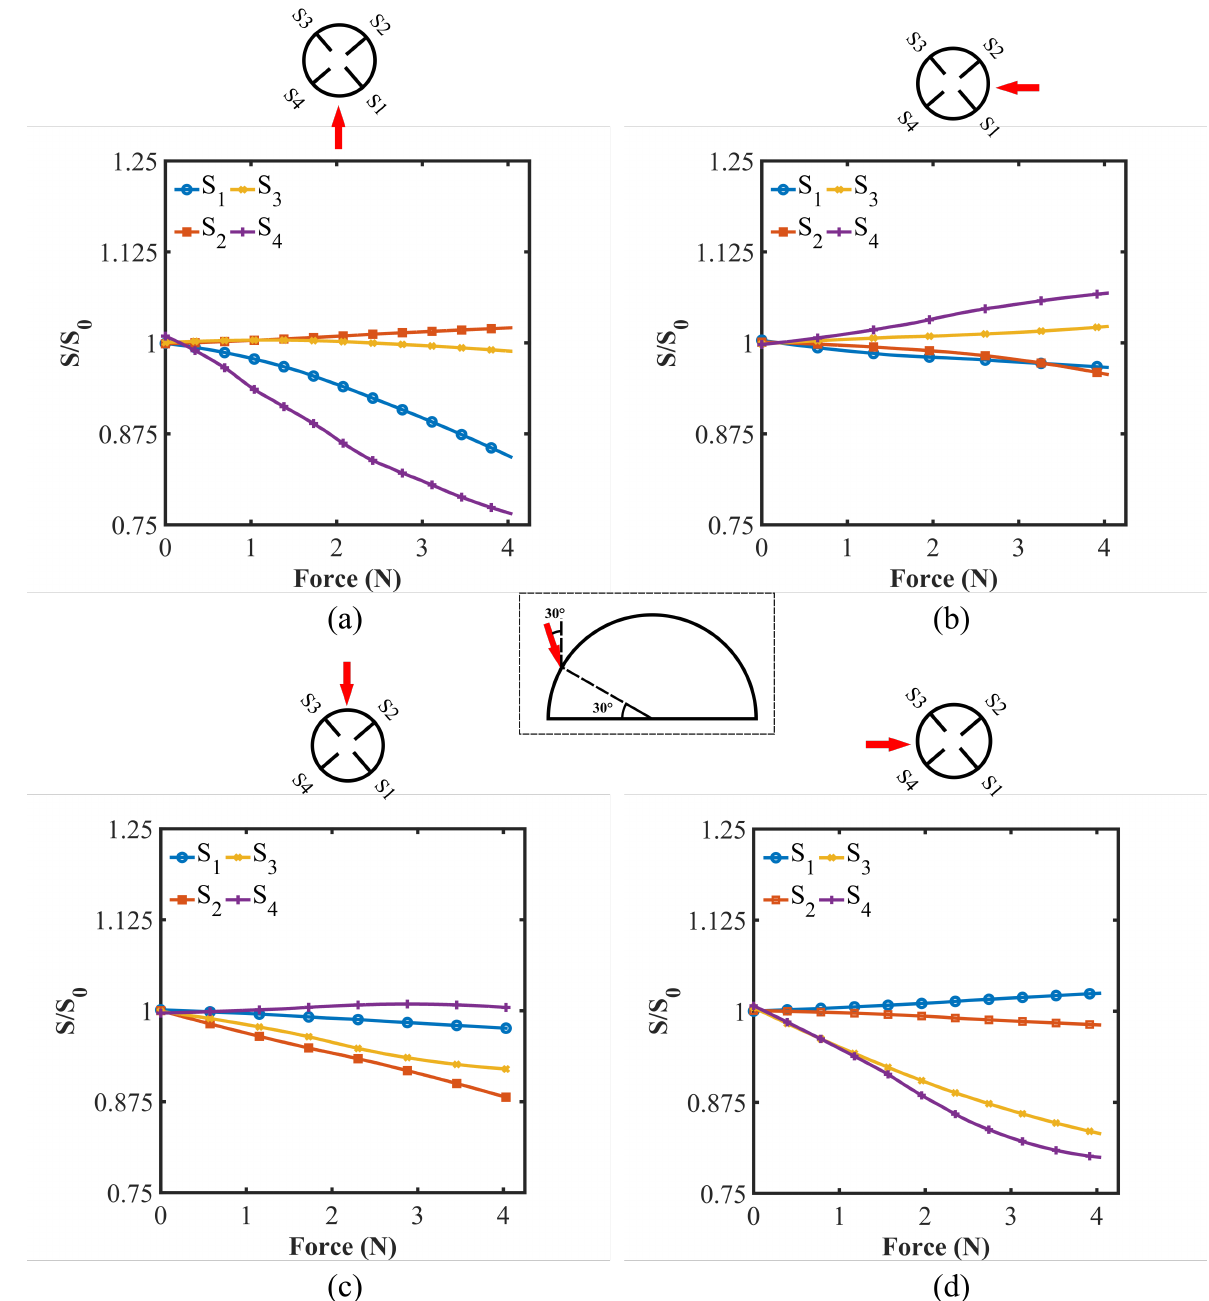
Figure 10. Readouts of the sensor against forces along 30 ◦ with vertical on the sides of the hemispher- ical sensor at 30 ◦ latitude (in between inserted two consecutive ( a ) S 4 and S 1 , ( b ) S 1 and S 2 , ( c ) S 2 and S 3 , and ( d ) S 3 and S 4 flex sensors); top view of the sensor system is shown and the red arrow illustrates the applied force